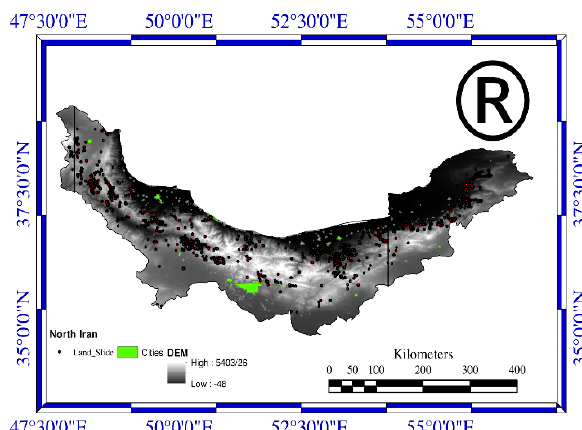
Figure 1. Location of the study area.